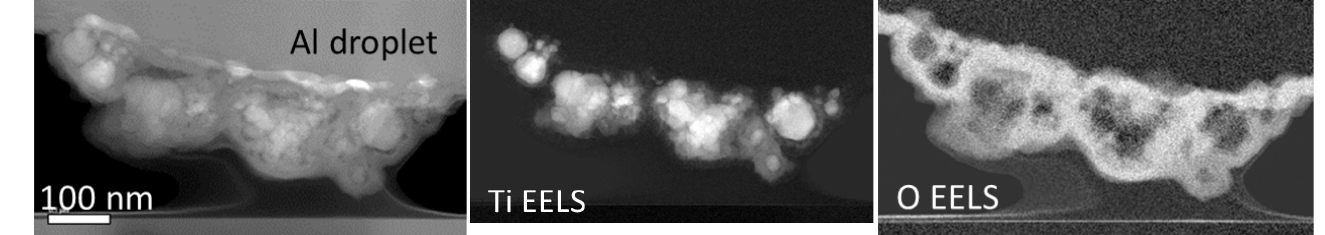
Figure 8. STEM/EELS cross section image, which has been prepared by FIB from a single 7075/TiC particle after rapid solidification by DFSC.